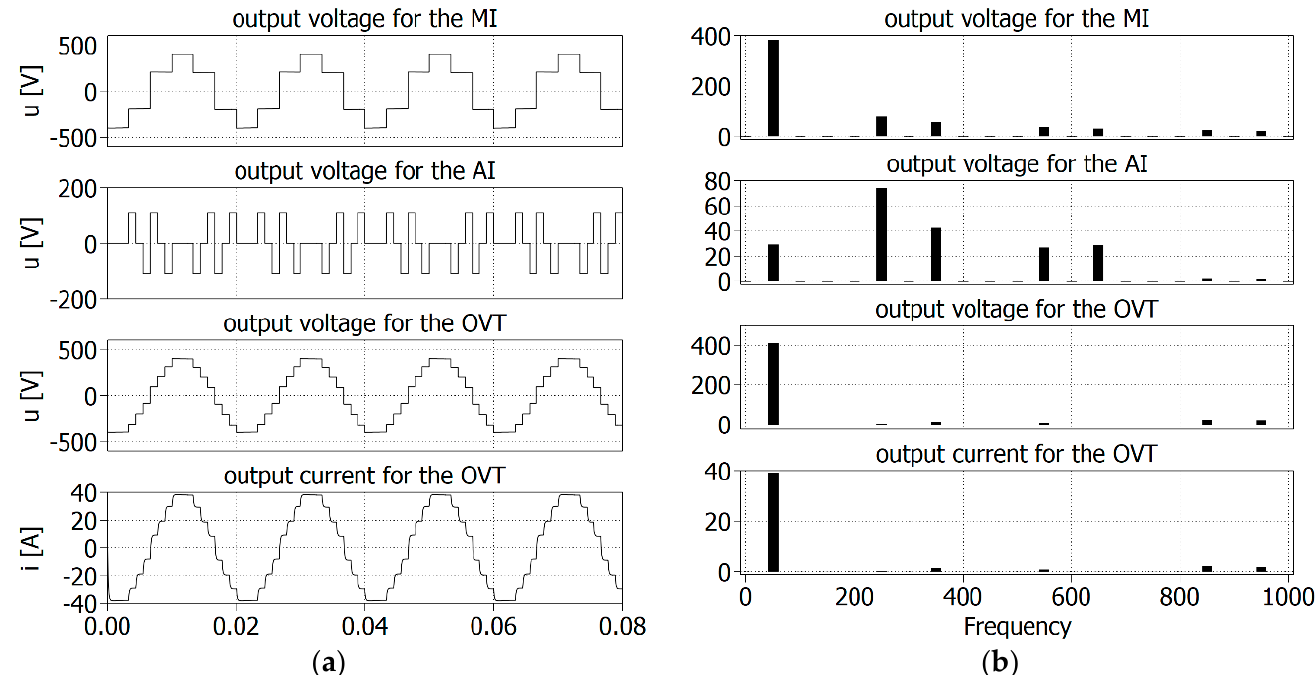
Figure 4. The model of an OVT inverter with a summing circuit in the form of transformers and a resistive load created using the PLECS program.